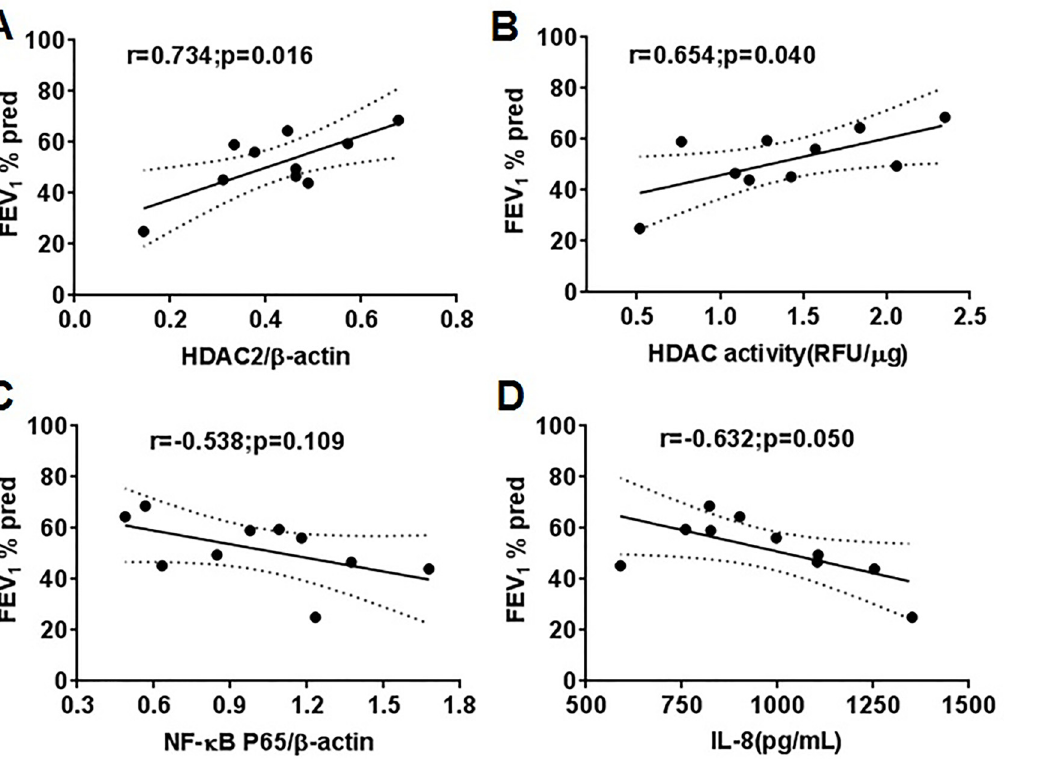
Fig 3. Correlation between FEV 1 %pred with HDAC2 expression, HDAC activity, NF- κ B p65 expression and serum cytokine levels in COPD patients. (A) FEV 1 %pred and HDAC2 expression in PMBCs. (B) FEV 1 %pred and HDAC activity in PBMCs. (C) FEV 1 %pred and NF- κ B p65 expression in PBMCs. (D) FEV 1 %pred and serum IL-8 level. RFU relative fluorescence